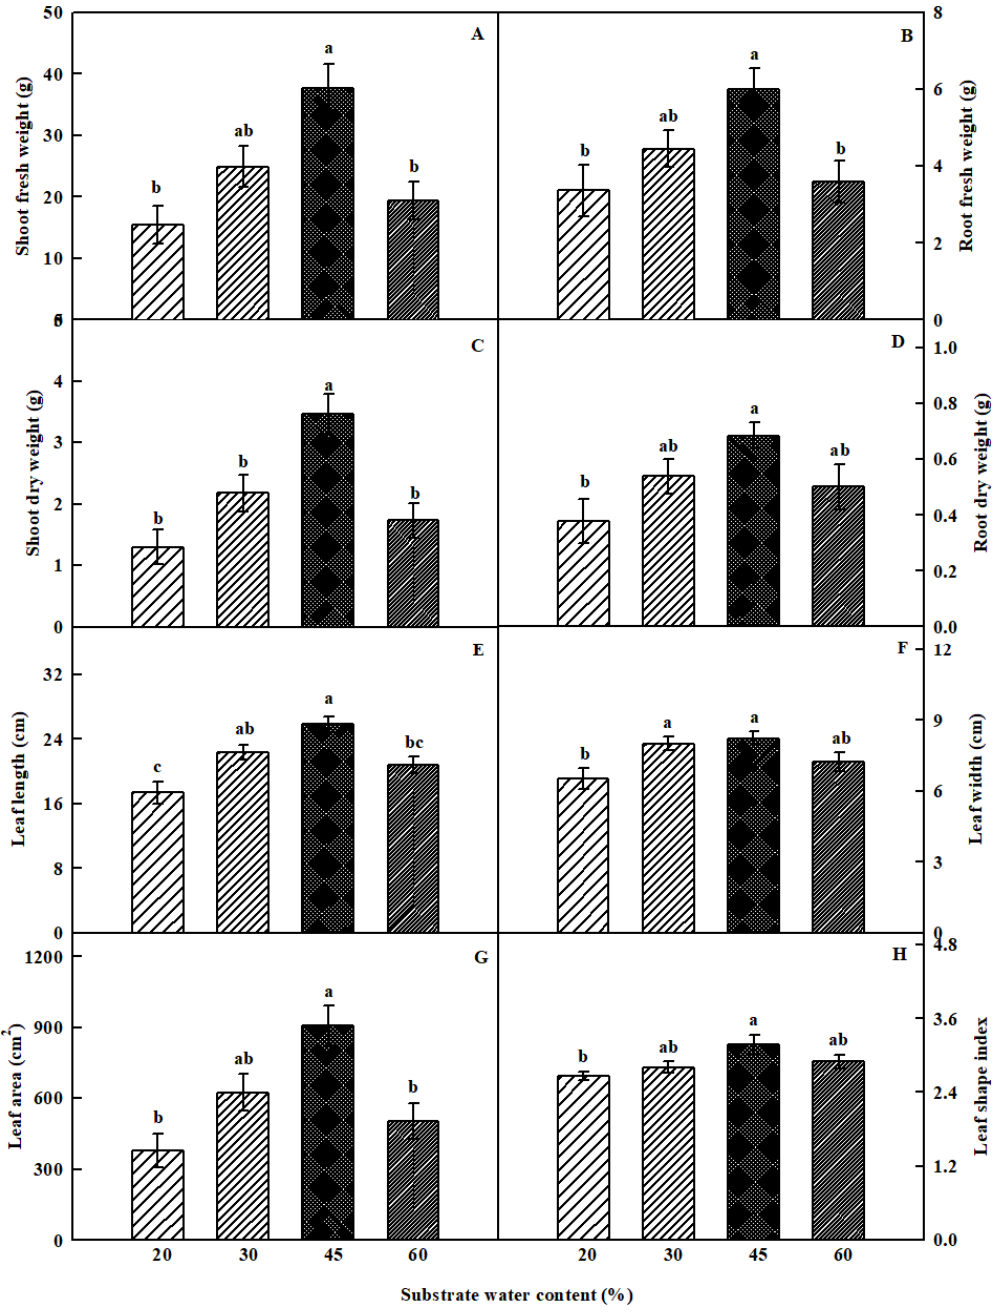
Figure 2. Effect of substrate water content on growth parameters: Fresh and dry weighs of shoot ( A and C ) and root ( B and D ), leaf length ( E ), leaf width ( F ), leaf area ( G ) and leaf shape index ( H ) of under four di ff erent substrate water content levels for 5 weeks. The data indicate the means ± S.E. ( n = 12). Di ff erent letters above the bars indicate statistical di ff erence by Tukey’s Studentized Range Test at p <